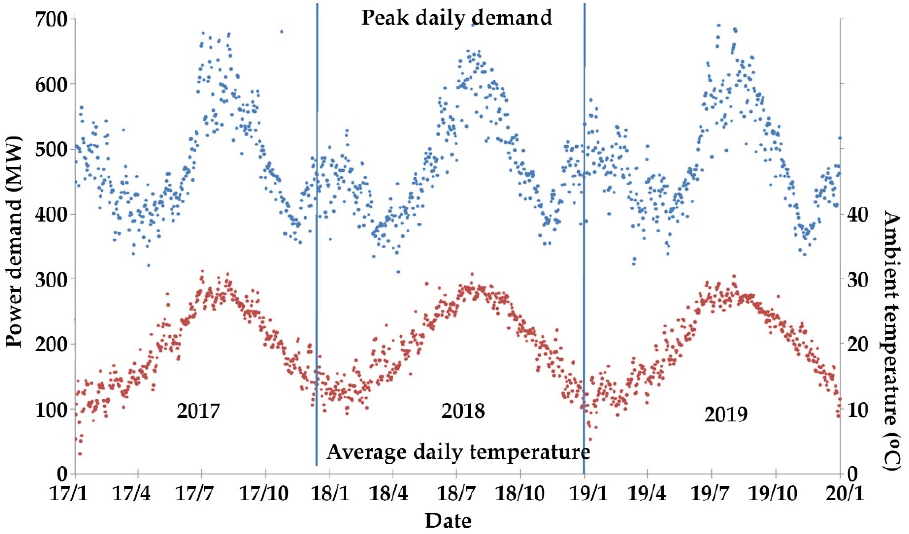
Figure 6. Annual fluctuation in the daily peak demand in Crete for three consecutive years [50]. It is observed, as was expected, that the power demand in Crete is maximized during summertime, a noticeable boost which is obviously due to tourism and the need for cooling, while there is a slight increase too during winter time. This slight increase in the wintertime energy consumption is attributed to the gradual transfer of the heating needed to obtain full coverage from the conventional to the alternative heating technologies and specifically from oil-fired boilers to the heat pumps. The seasonal fluctuation in the power demand is also depicted in the annual power demand time series of 2019 (Figure 7).